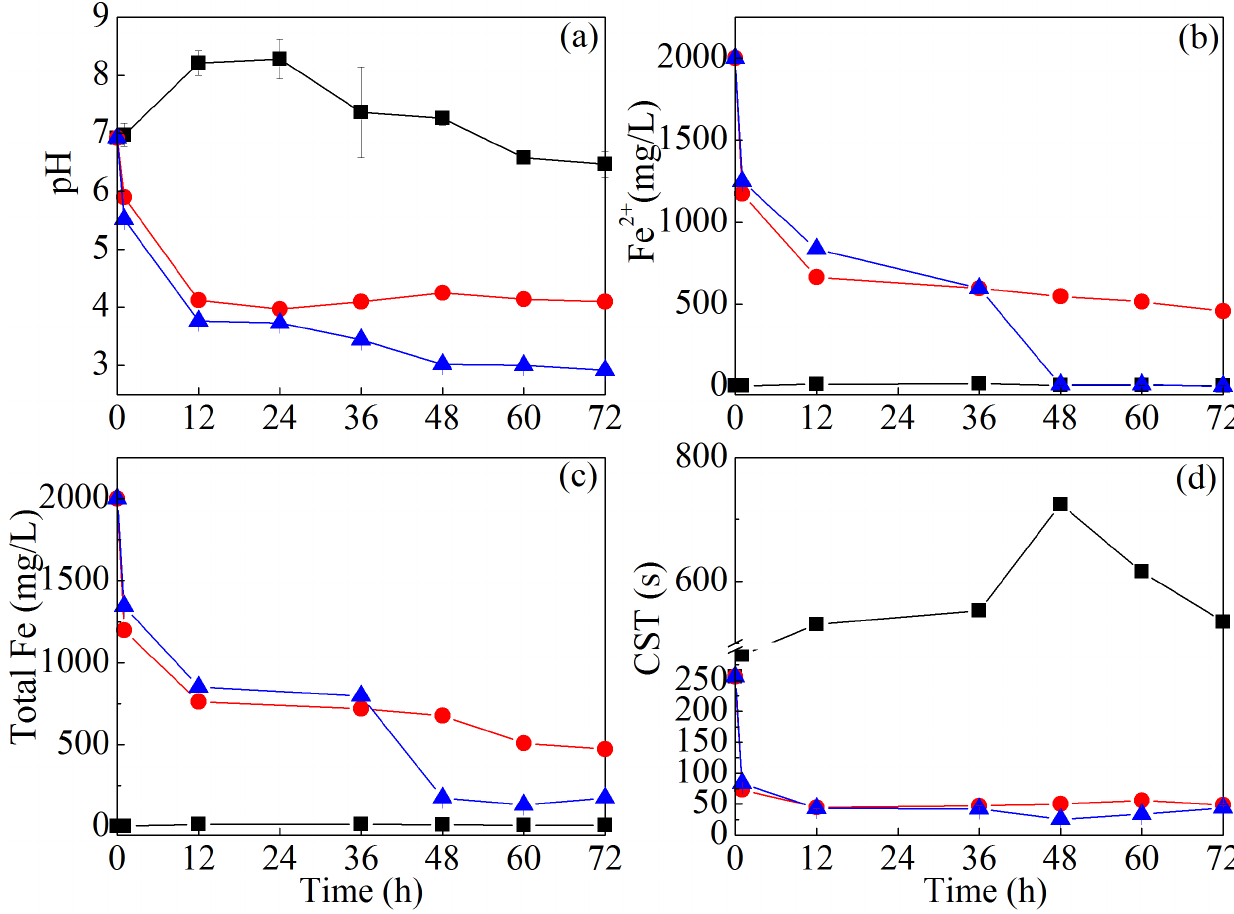
Figure 1. Changes of sludge pH, concentrations of Fe 2 + and total Fe, and sludge CST during the sewage sludge bioleaching. ( & CK1, # CK2, g A.t + A.f